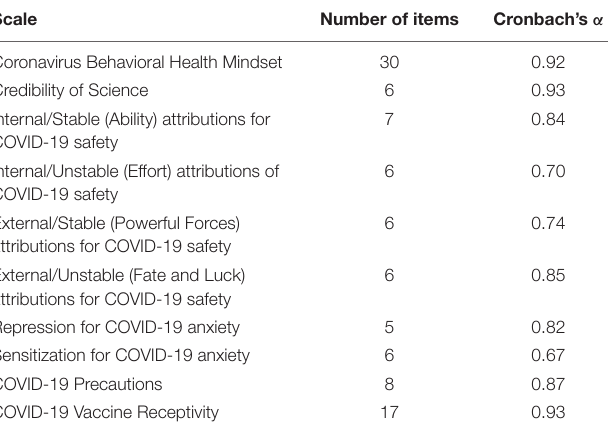
TABLE 2 | Reliability of assessments (Study